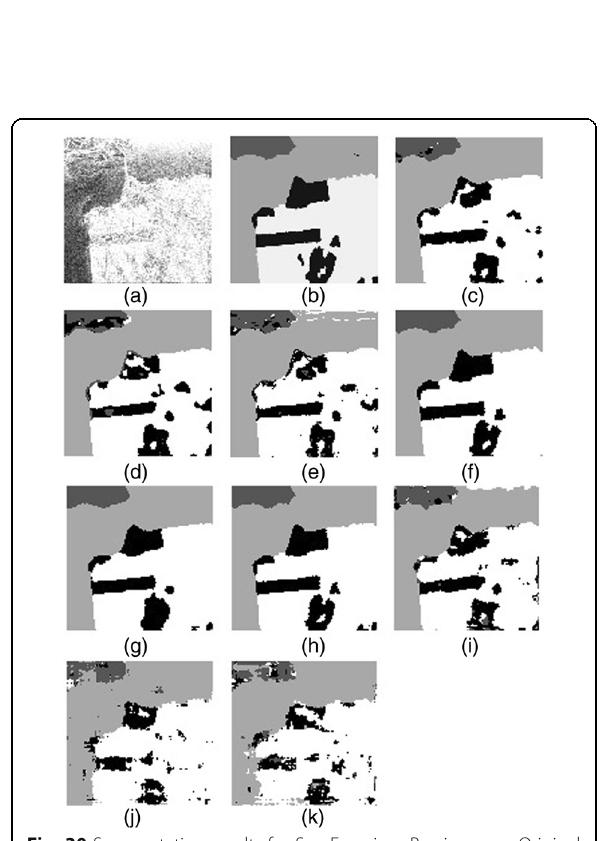
Fig. 30 Segmentation results for San Francisco Bay image. a Original image. b Hand-segmented image. c Gaussian features. d Rayleigh features. e Alpha-stable features. f Gaussian + contourlet features. g Rayleigh + contourlet features. h Alpha-stable + contourlet features. i Fractal dimension. j Fractal + contourlet. k Alpha-stable+